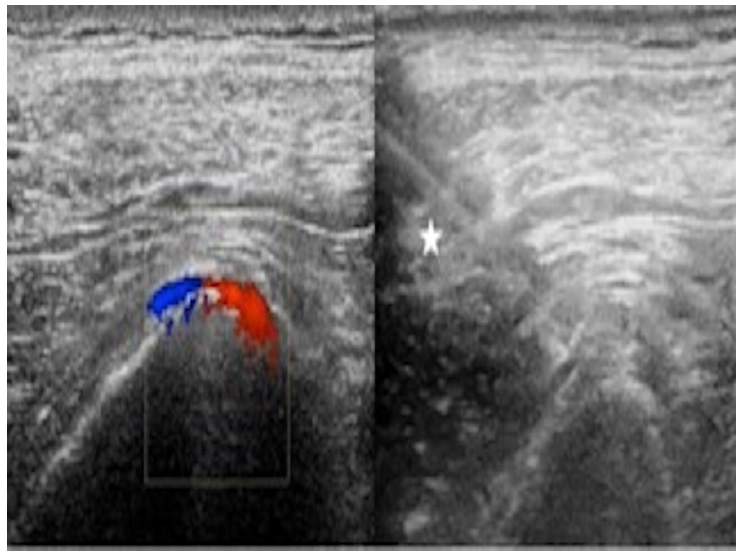
Figure 2. Color Doppler and gray-scale ultrasound of the gluteal region demonstrating patent superior gluteal artery that was accessed under ultrasound guidance (*).